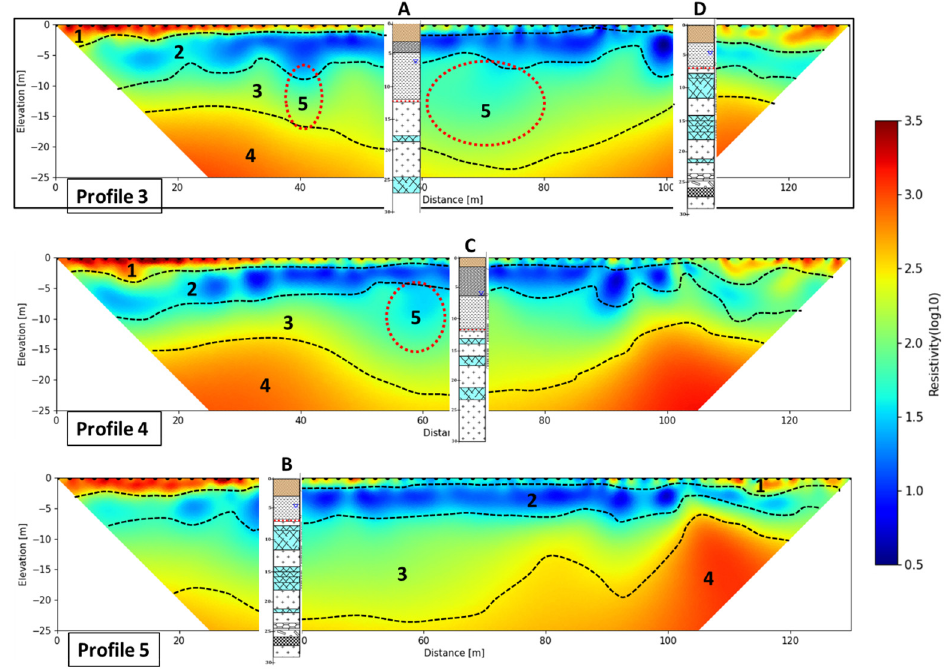
Figure 8. Selected subsurface resistivity models from inversion of ERT data for ( top ) profile 3, ( middle ) profile 4, and ( bottom ) profile 5. Lithological logs for wells A–D are placed on the corresponding resistivity profiles.